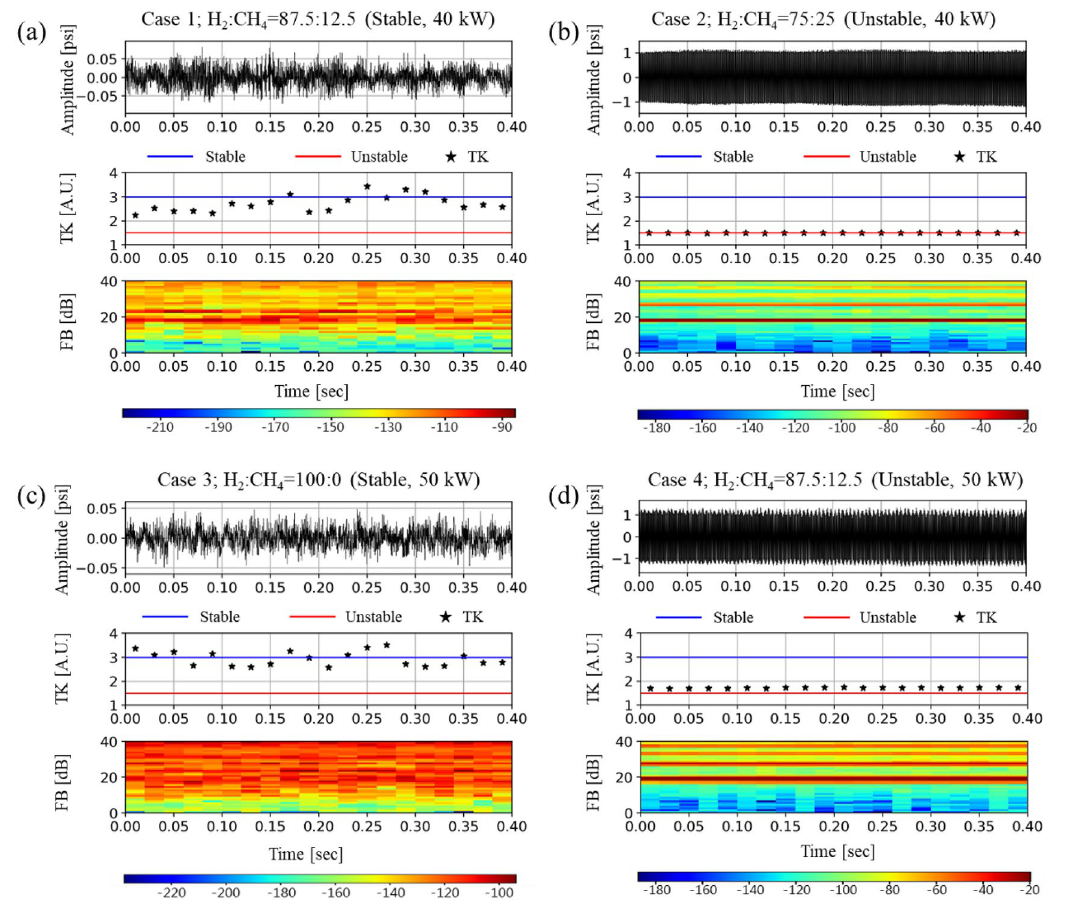
Figure 7. Dynamic pressure signal, temporal kurtosis, and FB components for each fuel composition. ( a ) FB